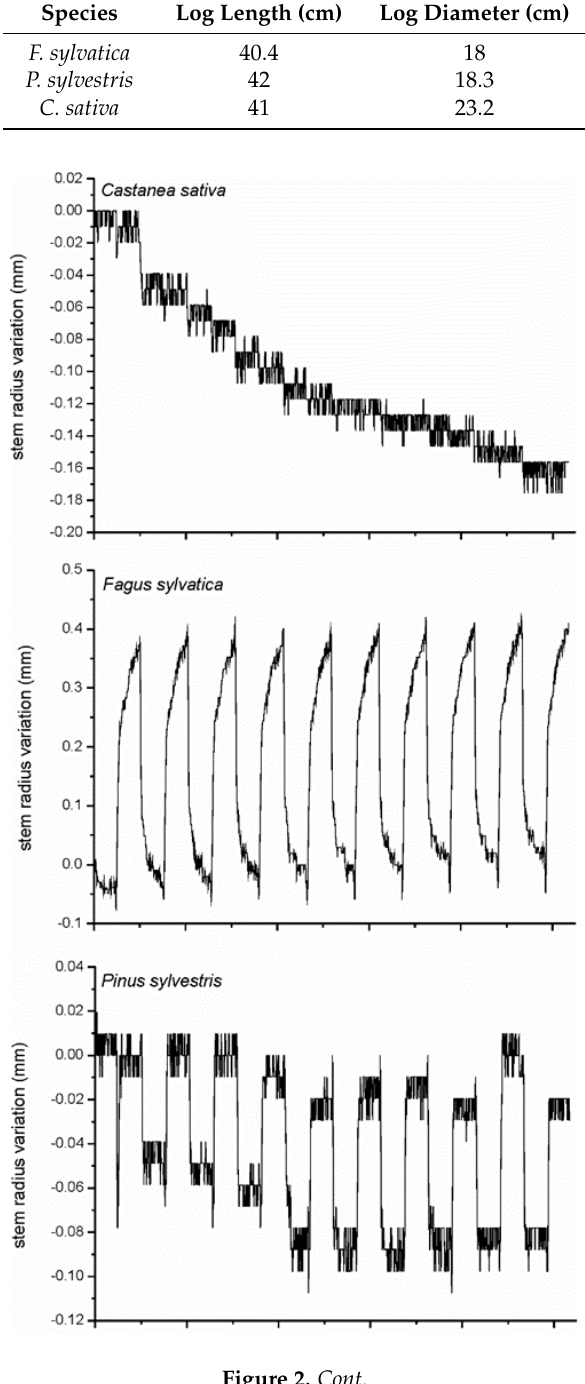
Figure 2. Cont. Figure 2.